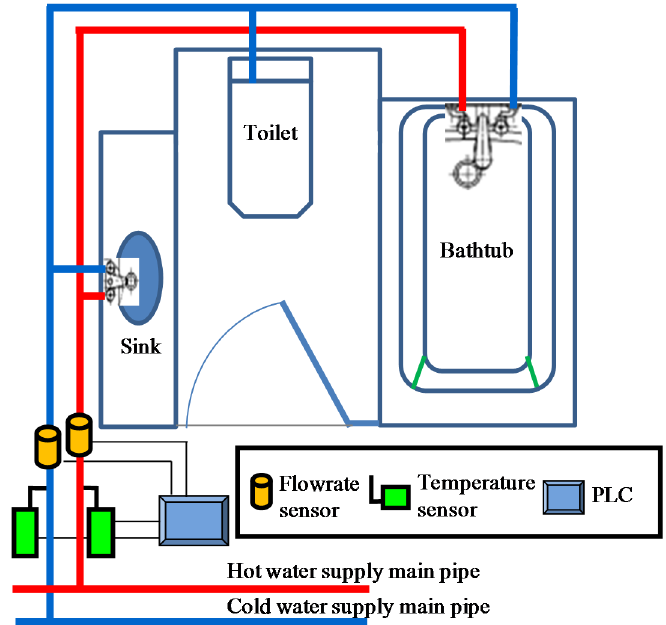
Figure 2. The bathroom plan and the measurement points.